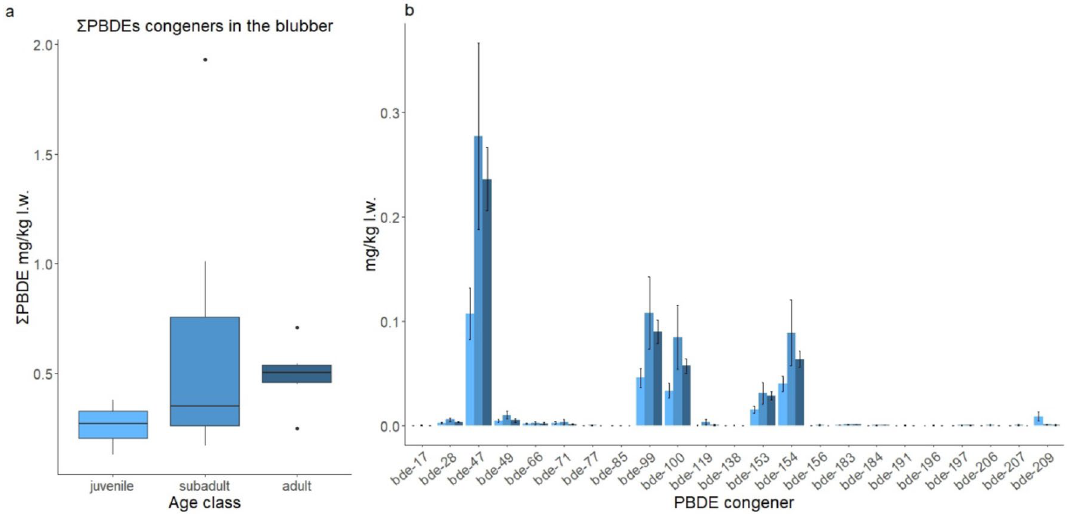
Figure 3. PBDE levels in the blubber of Cuvier’s beaked whale in the three age classes: juvenile (light blue), subadult (medium blue) and adult (dark blue). ( a ) Boxplots showing ΣPBDE concentrations (mg/kg lipid weight) in blubber of Cuvier’s beaked whale of juvenile (n = 4), subadult male (n = 8) and adult male (n = 6). ( b ) The mean values of the individual PBDE congener for all 27 PBDE congeners, in the age classes. Error bars represent standard errors